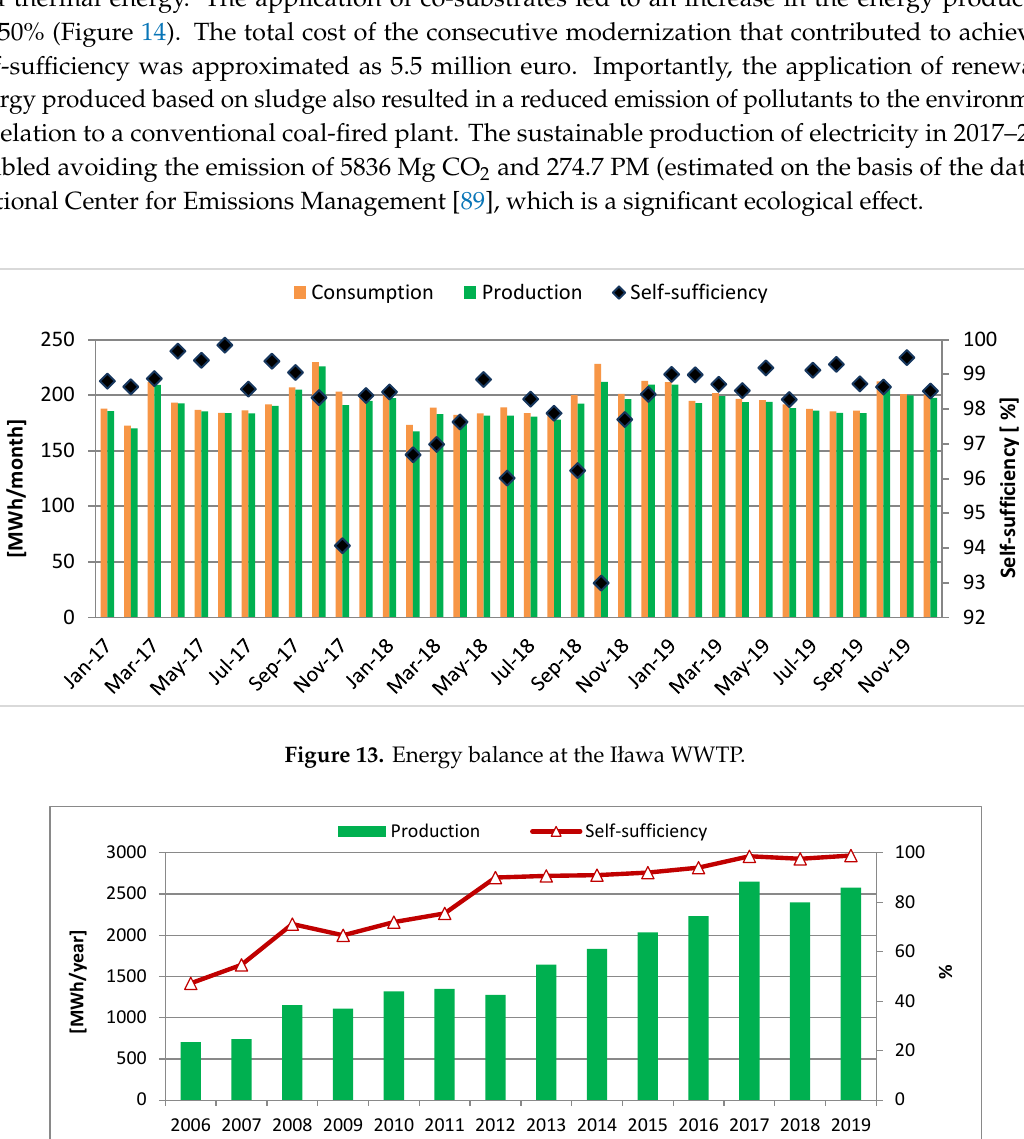
Figure 14. Energy balance for the Iława WWTP .